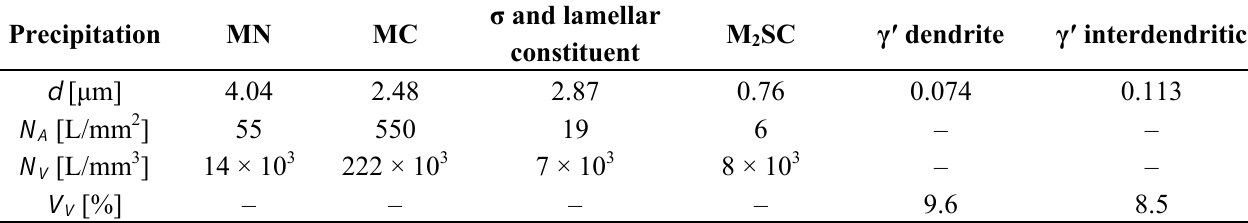
Table 3. Size and distribution frequency of secondary phases in the as-cast Haynes ® 282 ® alloy (metallic carbides (MC), metallic nitrides (MN)).